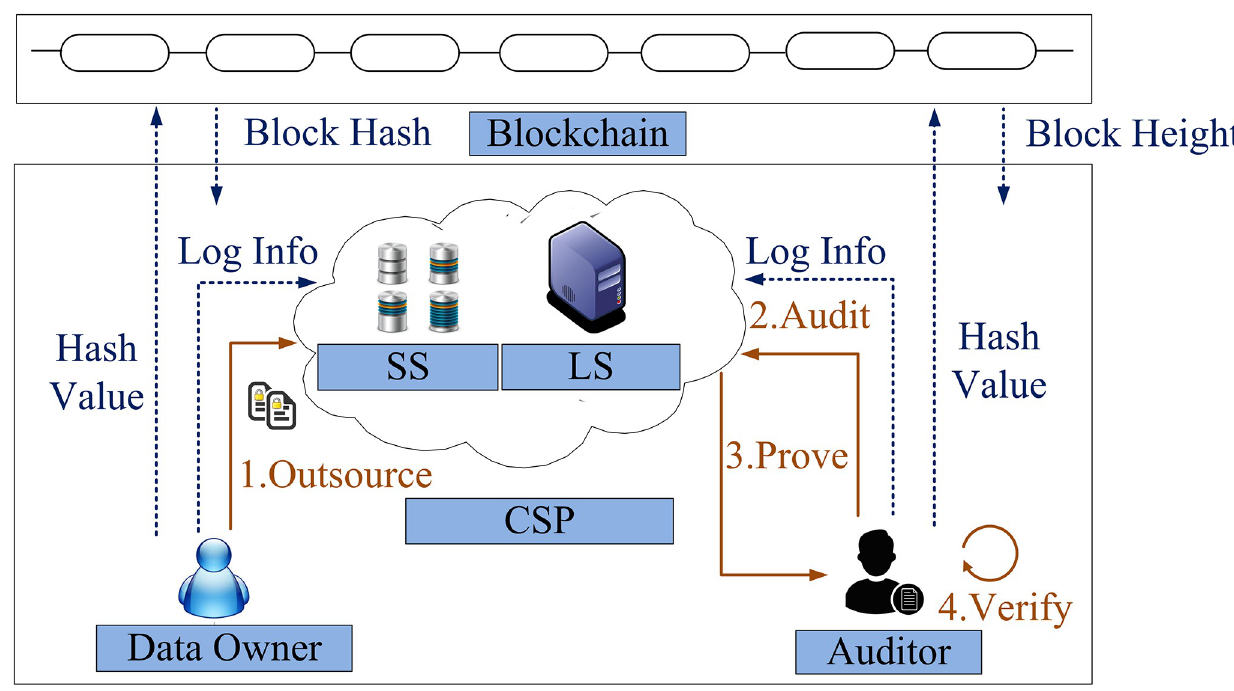
Fig 1. Framework of